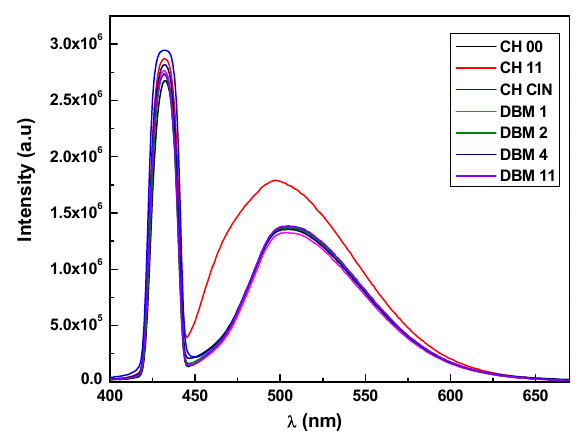
Figure 6. Fluorescence spectra of the different compounds tested.